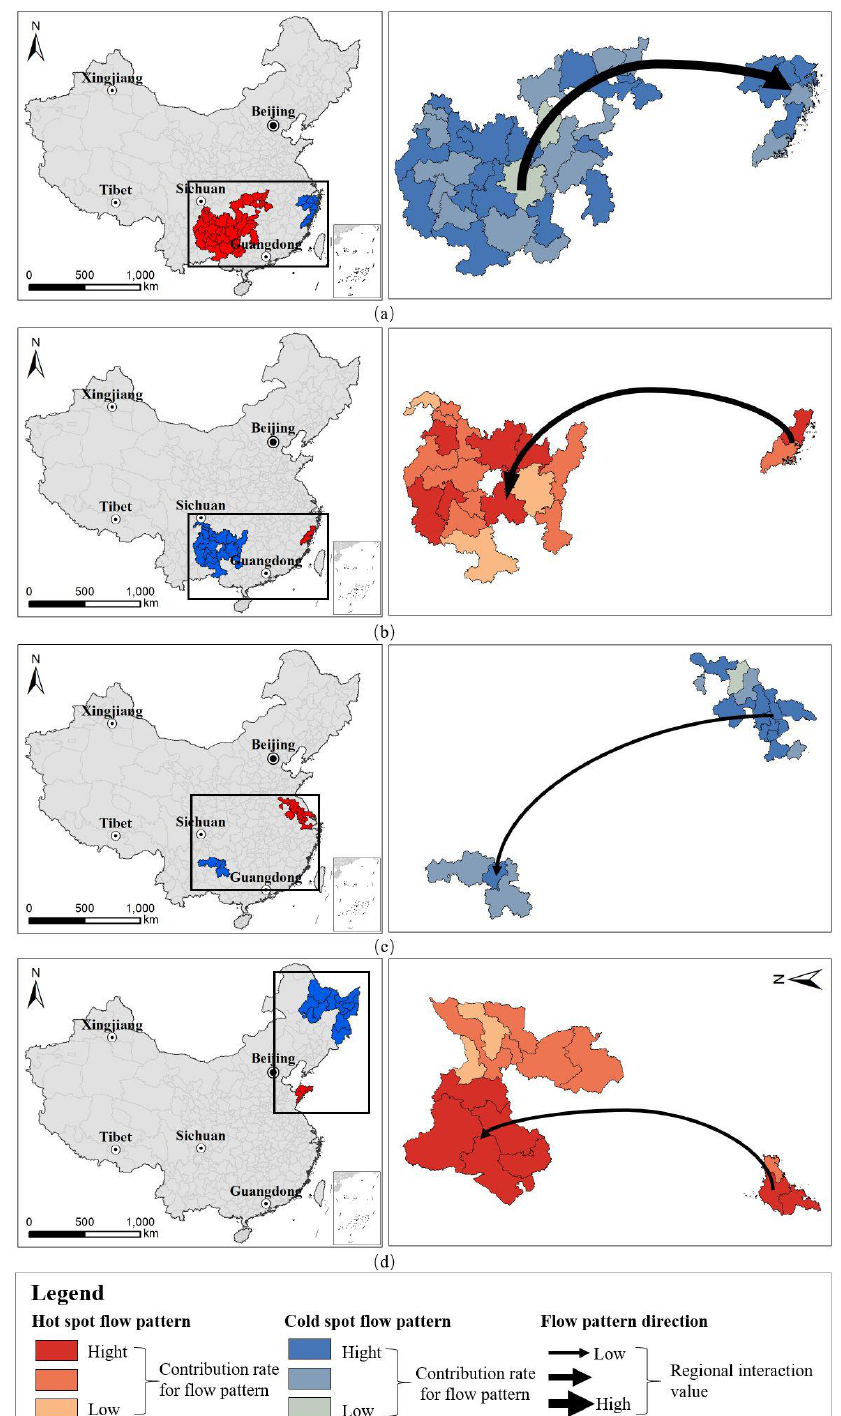
Figure 10. Four examples of RG-Flow-Patterns geo-information Tupu obtained under the threshold of 0.00001. ( a ) A cold-spot RG-Flow-Pattern; ( b ) a hotspot RG-Flow-Pattern; ( c ) a cold-spot RG-Flow-Pattern; ( d ) a hotspot RG-Flow-Pattern.